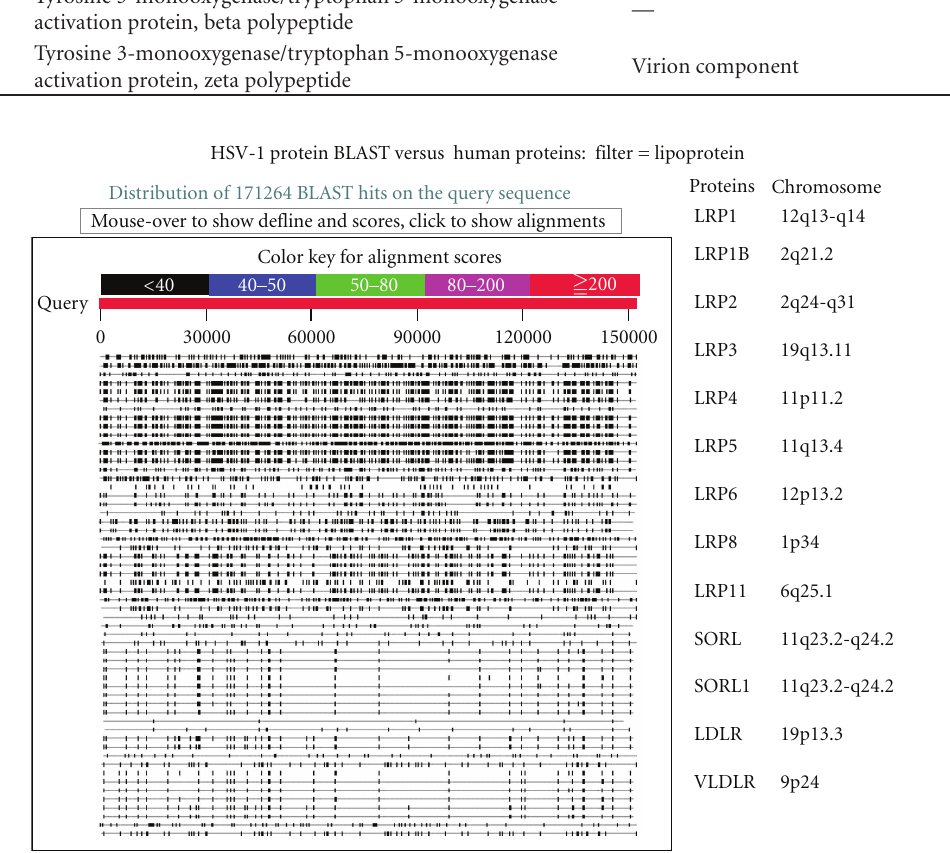
Figure 1: The BLAST result for HSV-1 proteins (translated viral genome versus human proteins) using the filter “lipoprotein.” The repetitive patterns in the pictogram reflect homology with a number of di ff erent lipoprotein receptors located on di ff erent chromosomes, as shown in the